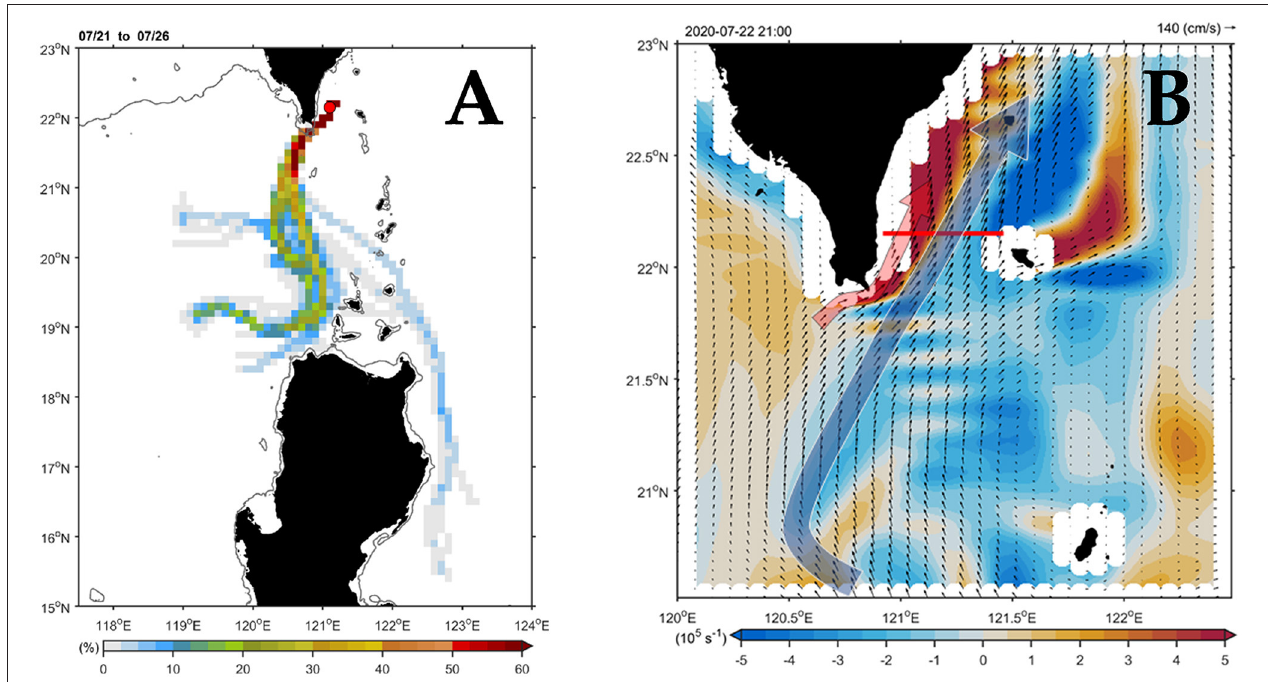
FIGURE 2 | Three-dimensional numerical simulation of flow patterns in the study area. (A) Paths of the currents based on the backward-trajectory analyses. The horizontal color bar indicates the percentage for the arrival of the floater. The percentage is 100% in the releasing position (station 2; red dot; 22.15 ◦ N, 121.1 ◦ E). (B) Simulated flow patterns of the 15-m depth velocity (vector) and vorticity (shading) on July 22, 2020. The red line in (B) indicates the sampling